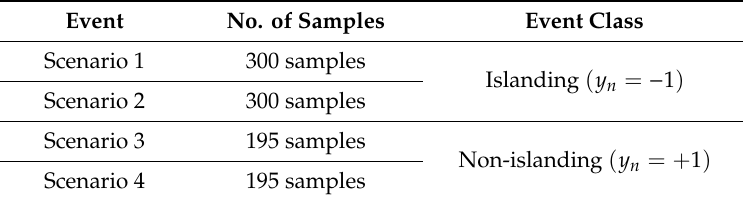
Table 3. Islanding events and their samples.